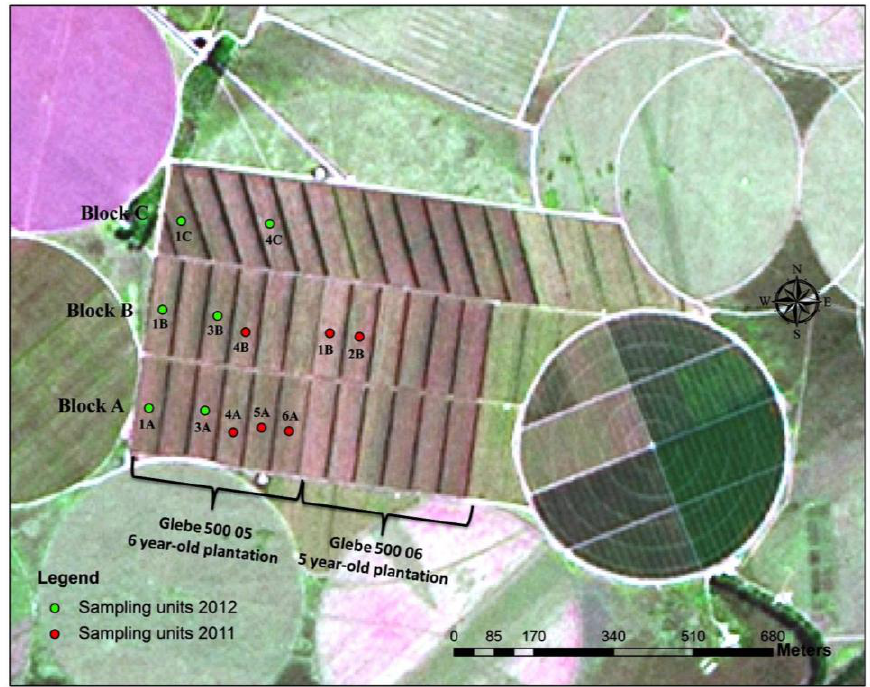
which constitutes an apple orchard in the Bagisa Company farm (X: 238,519.993 UTM; Y: 8,531,325.085 UTM) in the municipality of Ibicoara (State of Bahia, Brazil). The apple orchard is divided into three blocks (A, B and C) comprising 36 parcels (1.2 ha or 60 × 200 m each); each block has 12 parcels. The orchard area is divided into two 18-parcel grids (Glebe 500 05 and Glebe 500 06) according to the age of